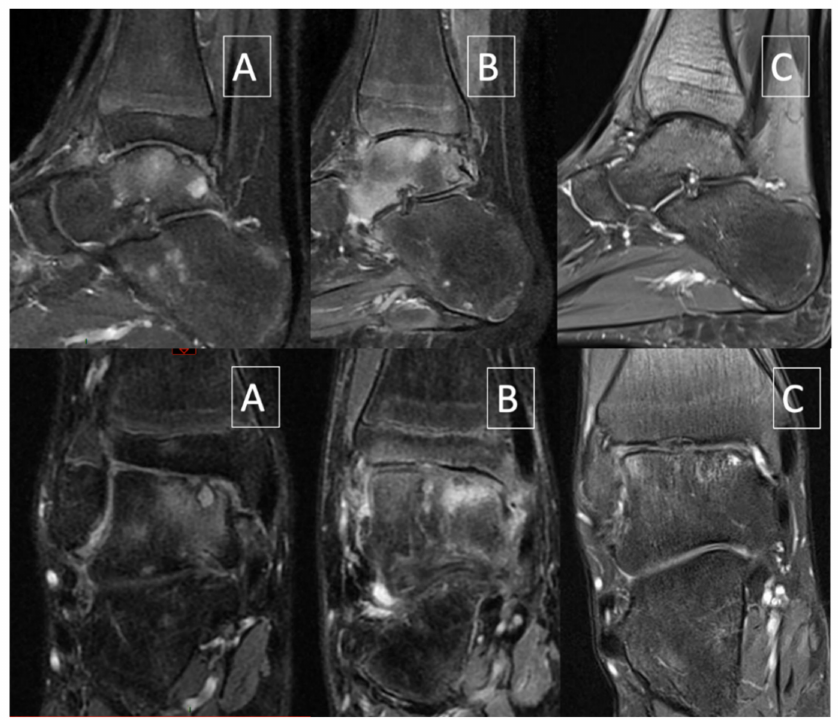
Figure 2. Sagittal and coronal fat-saturated proton density–weighted MRI. ( A ) June 2017 (4 months before ankle joint distraction): worsening of the cartilage lesion with collapse. ( B ) January 2018 (2 months after ankle joint distraction): edema with stable aspect of the cartilage lesion. ( C ) December 2019: decrease of edema and improvement of bony and cartilaginous lesions.